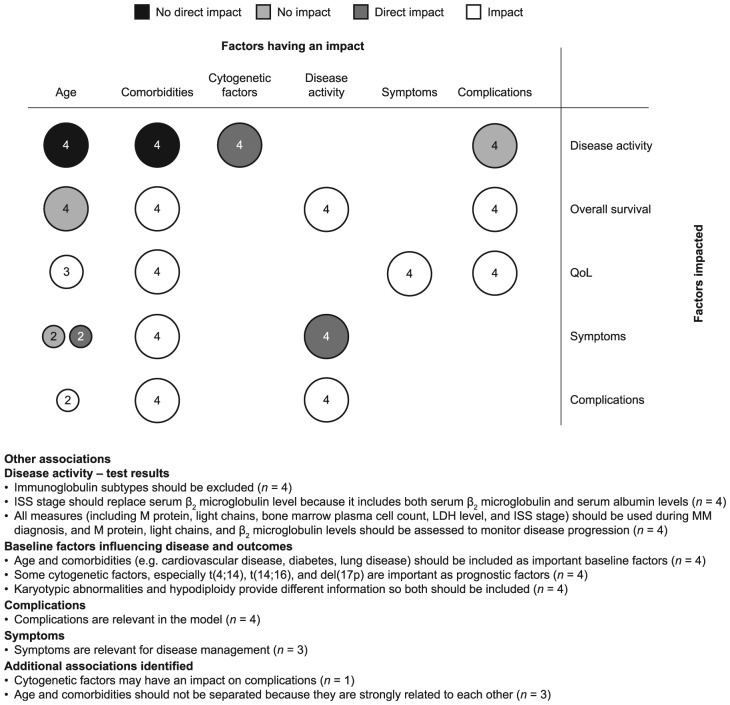
Associations between attributes agreed by the Delphi panel.ISS, International Staging System; LDH, lactate dehydrogenase; MM,
multiple myeloma; QoL, quality of life.The x-axis shows factors that were agreed to either
affect or not affect the factors on the y-axis. The
size of the circles and the numbers within show the strength of the
association in terms of how many Delphi panel members agreed. For
example, age has no direct impact on disease activity
(n = 4).